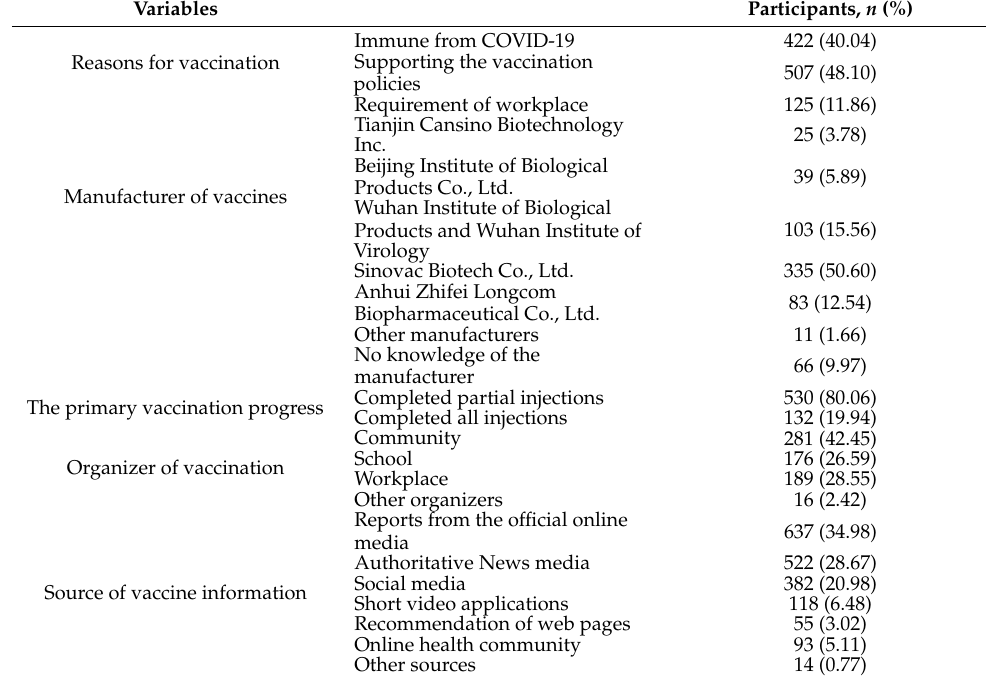
Table 2. Characteristics of Vaccinated Participants ( n = 662).